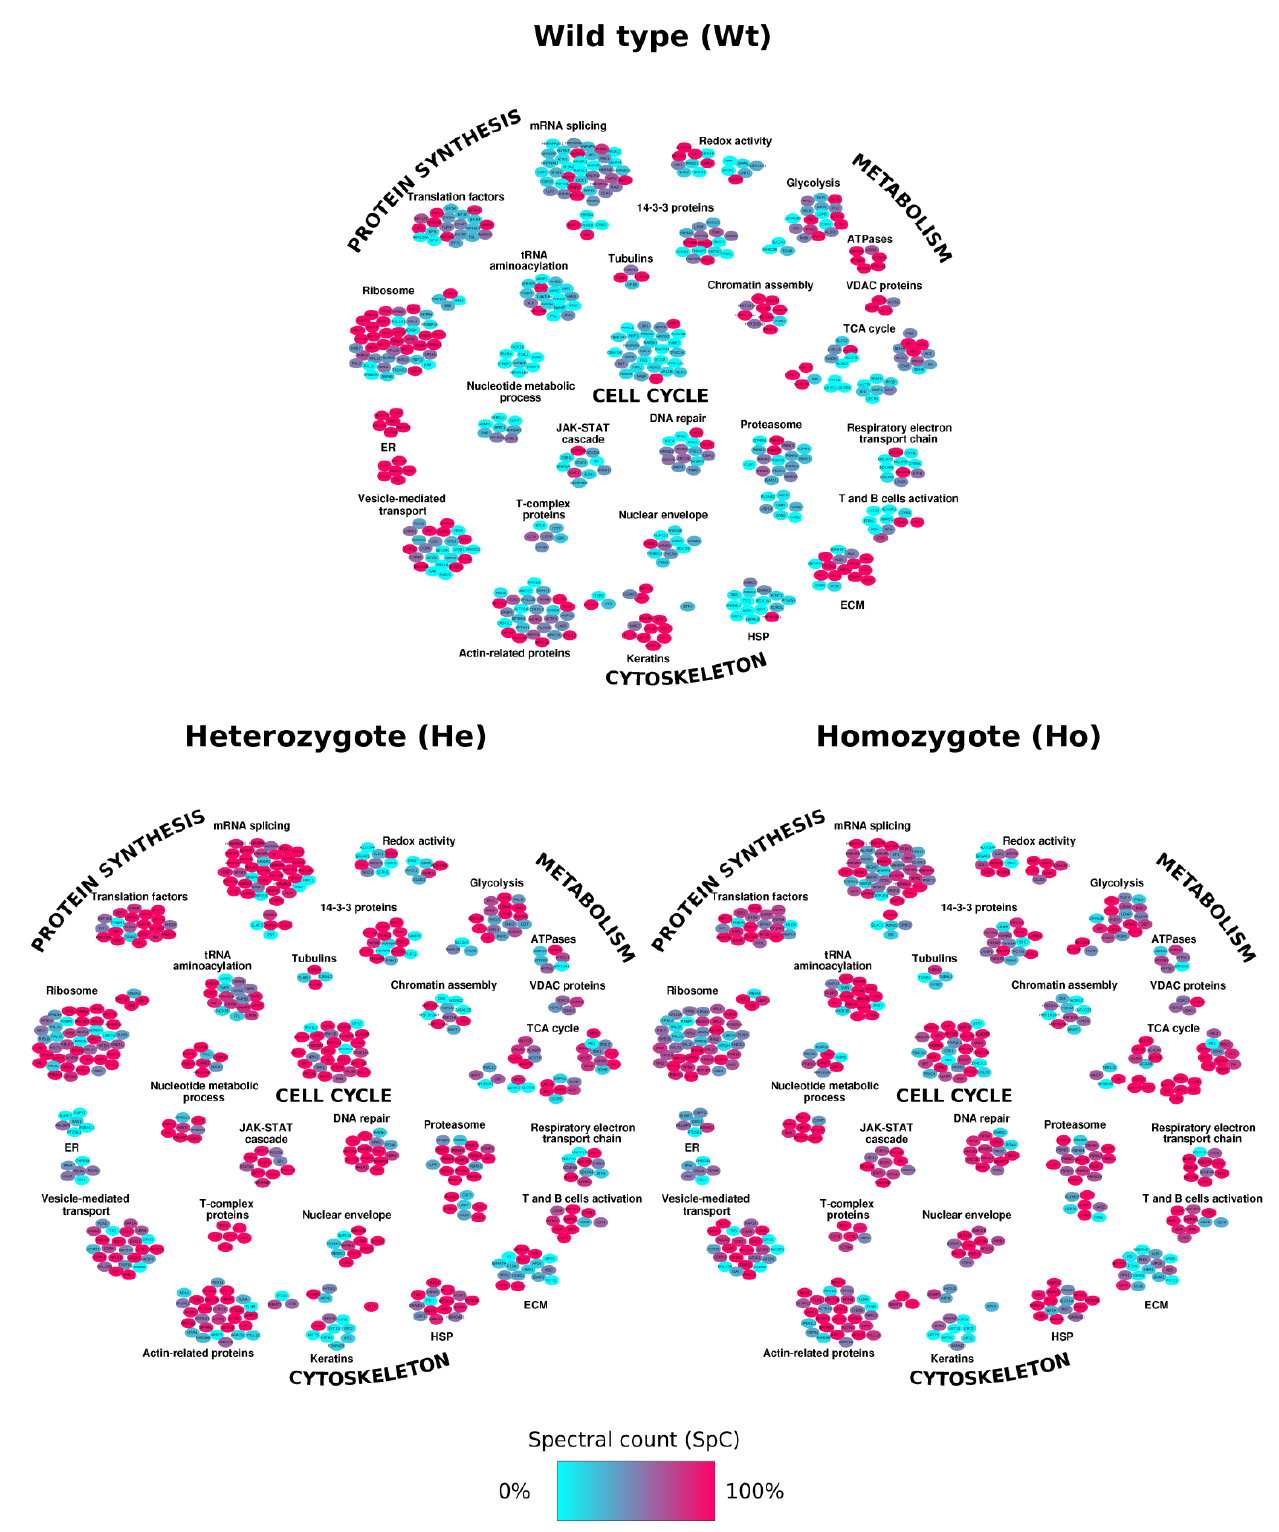
Figure 4. Protein–Protein Interaction (PPI) Network. Interactome network built for Wild type (Wt), Heterozygote (He) and Homozygote (Ho) subjects through the mapping of proteins found to be differentially expressed by LDA and MAProMa analysis. The color code of distinct nodes reflects the normalized SpC values of each examined condition.